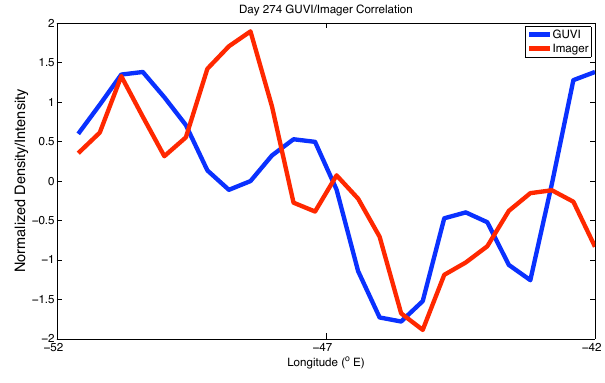
Fig. 5. Longitudinal correlation between the reconstructed GUVI electron density from 230-270 km and the latitude-integrated imager data from 2005 Day 274. Both datasets are normalized. The correlation coefficient between the two datasets is 0.51.